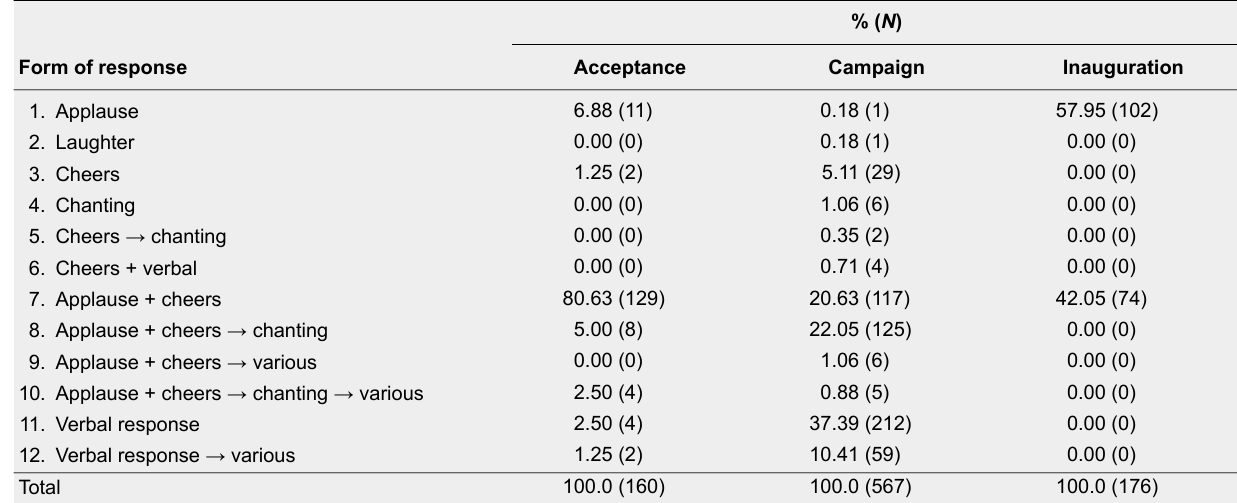
Forms of Audience Response by Three Speech